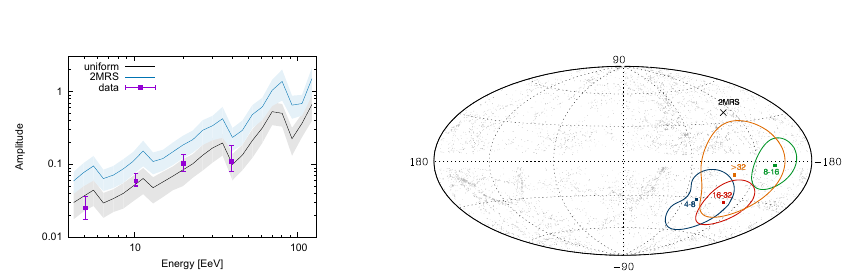
Figure 4. Left panel: Energy dependence of the dipole amplitude, together with the expectations from di ff erent extragalactic source scenarios [19]. Right panel: reconstructed dipole directions in the di ff erent energy